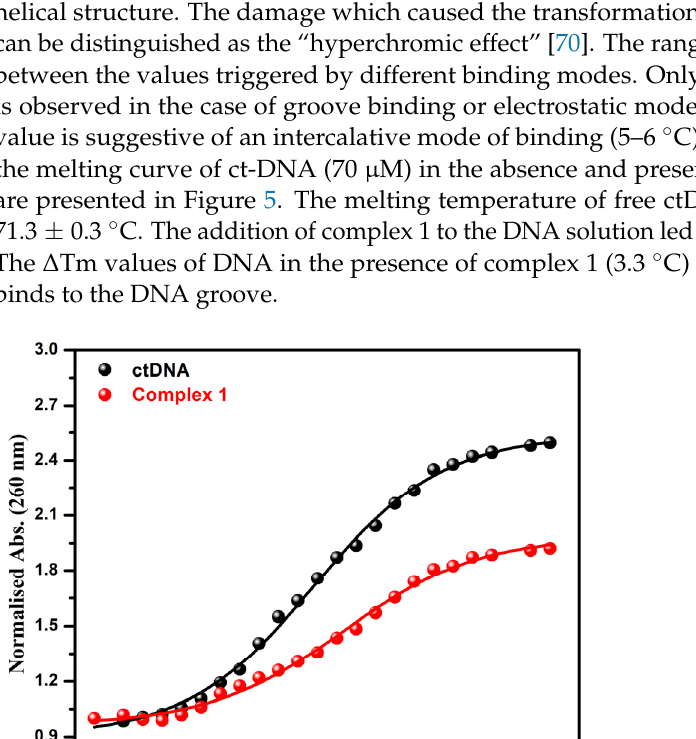
Figure 6. Relative viscosity ( η / η 0 ) 1/3 of ctDNA solution (30 μ M) in the presence of complex 1 at var- ying amounts (r) at 25 °C; r = [Complex 1]/[DNA]; 0.0, 0.05, 0.1, 0.15, 0.2, 0.25). 3.5. In Vitro Cytotoxicity The cytotoxicity of complex 1 was performed at various concentrations (0–20 μ M) against human colon cancer (HCT116) and human embryonic kidney 293 cells (HEK 293) using an MTT assay (Figure 7). In the case of the HCT116 cell line, more than 70% of cell